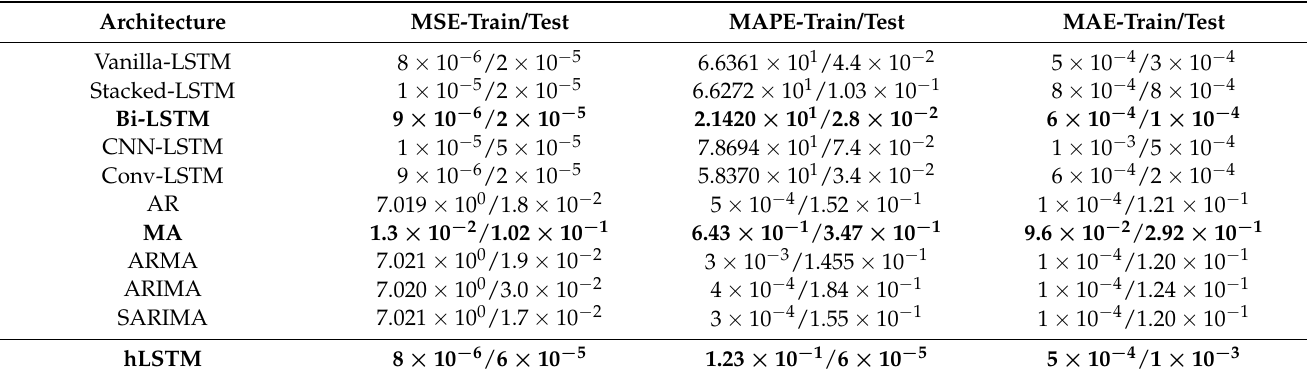
Table 2. Results of evaluation metrics for disk usage.